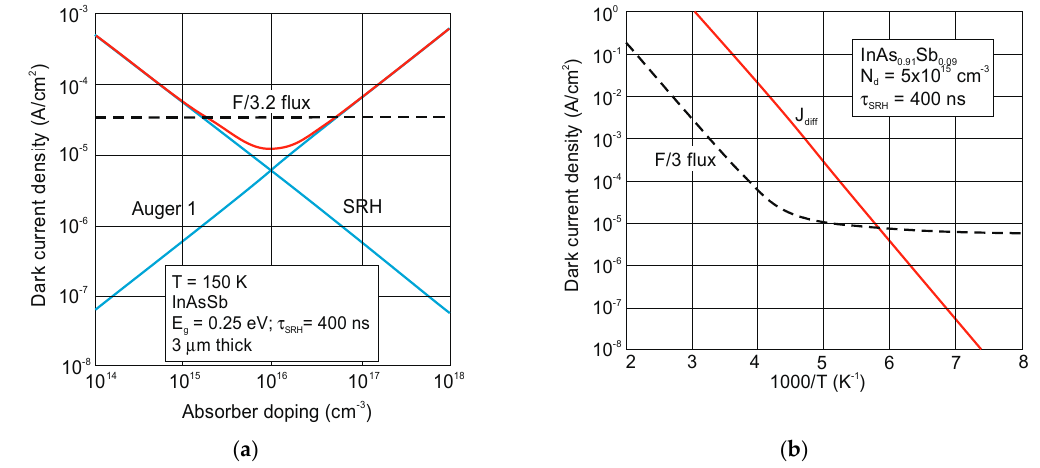
Figure 48. Dark current density for InAsSb nBn absorber ( τ SRH = 400 ns, t = 3 μ m): ( a ) versus doping concentration, and ( b ) versus inverse temperature for a donor doping 5 × 10 15 cm − 3 (after [78]).